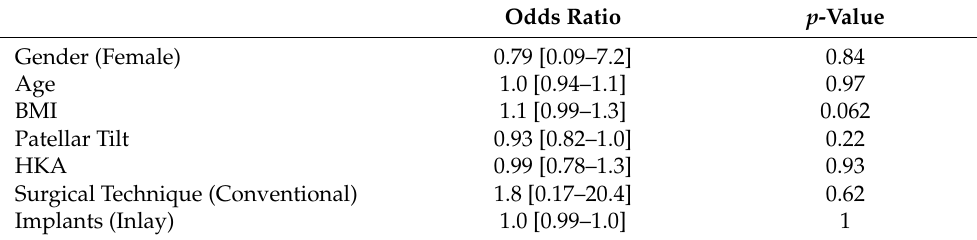
Table 4. Risk factors for poor outcomes after PFA: multivariate